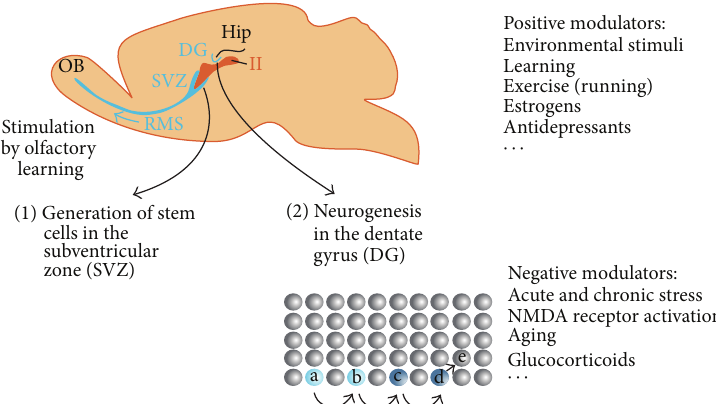
Figure1:Aschematicviewonadultneurogenesis.Neuronalprogenitorcellsaregeneratedinthesubventricularzone(SVZ)andinthedentate gyrus (DG) of the hippocampal formation (Hip). (1) In the SVZ, neuroepithelial progenitor cells are generated that migrate through the RMS (rostral migratory stream) to the olfactory bulb (OB). They differentiate to mature neurons and are integrated as functional elements into the neuronal olfactory circuitry. (2) In the DG, quiescent neural progenitors (a) become amplifying neural progenitors (b) that differentiate first to neuroblasts (c), then to immature neurons (d), and finally to functionally mature granule neurons